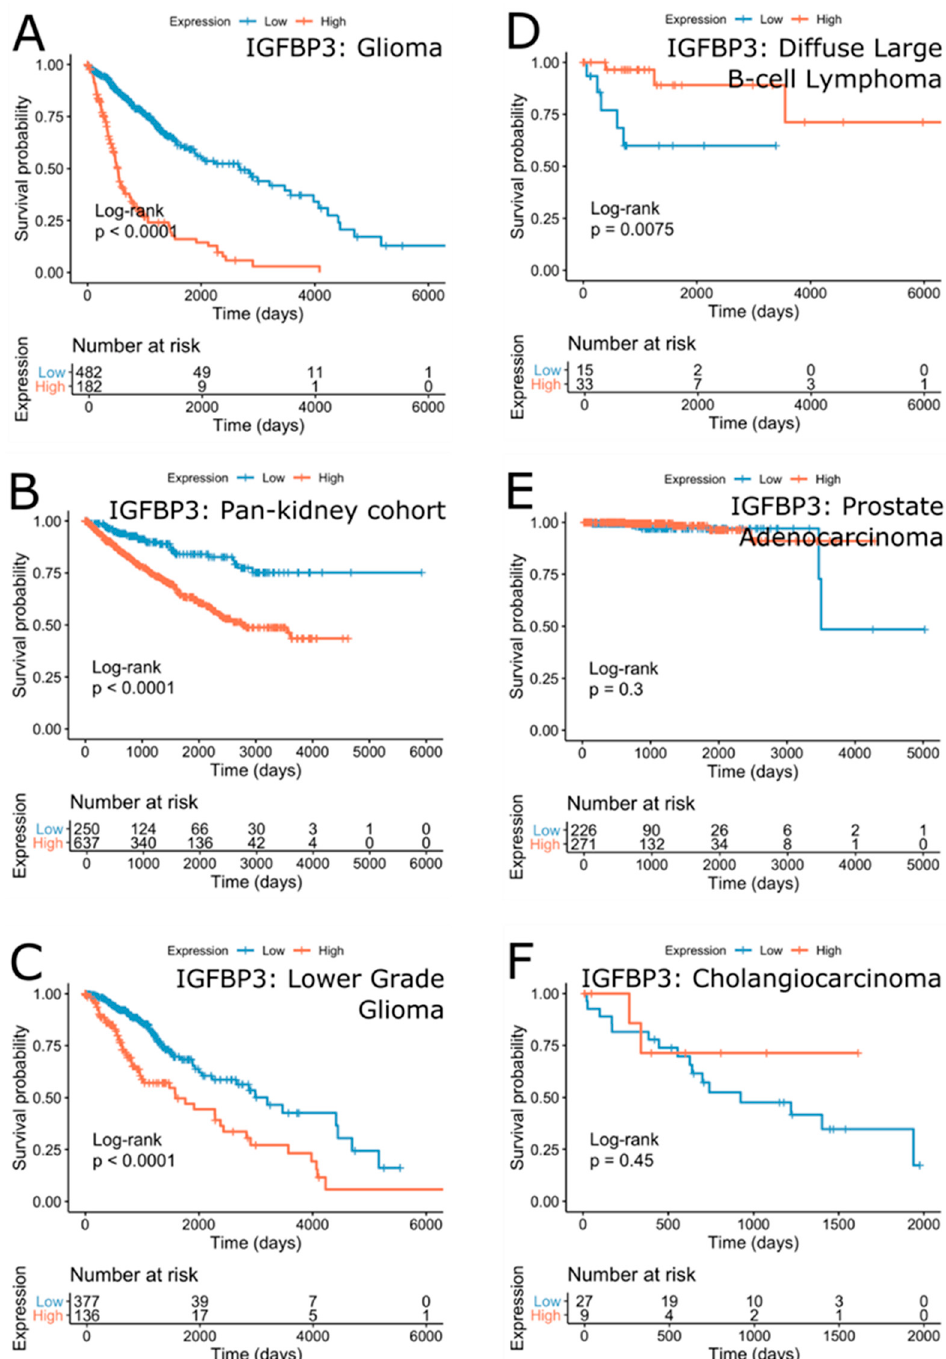
Figure 6. Kaplan-Meier plots of top cancers with survival outcomes separated by the expression of IGFBP-3 with a negative correlation ( A – C ) and a positive correlation ( D – F ). Unadjusted p -values are shown.